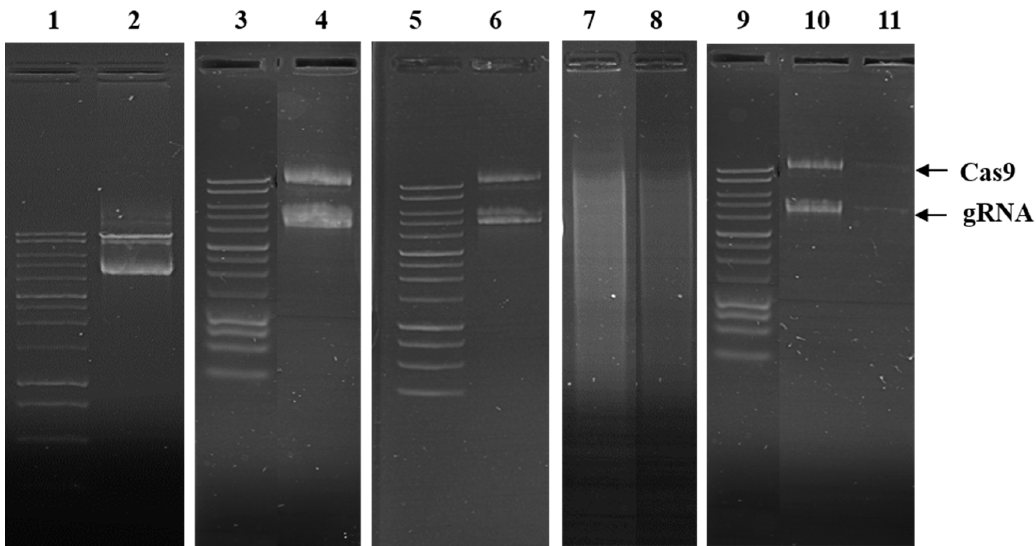
Figure 6. Integrity of CRISPR pDNA after encapsulation. Lanes: ( 1 ),( 3 ),( 5 ),( 9 ) are 1 kb ladder, ( 2 ) mixture of CRISPR plasmids (gRNA and Cas9), and ( 4 ) CRISPR plasmids (gRNA and Cas9) extracted from CRISPR ALG NPs. Stability of CRISPR ALG NPs in the presence of serum after 1 and 24 h incubation; ( 6 ), ( 8 ) are CRISPR ALG NPs incubated in 10% v/v fetal bovine serum (FBS) for 1 and 24 h, respectively, ( 7 ) mixture of naked CRISPR pDNA, gRNA, and Cas9 incubated in 10% v/v FBS for 1 h. Stability of released CRISPR pDNA from ALG NPs; ( 10 ),( 11 ) are the released CRISPR pDNA at 12 and 24 h time point.